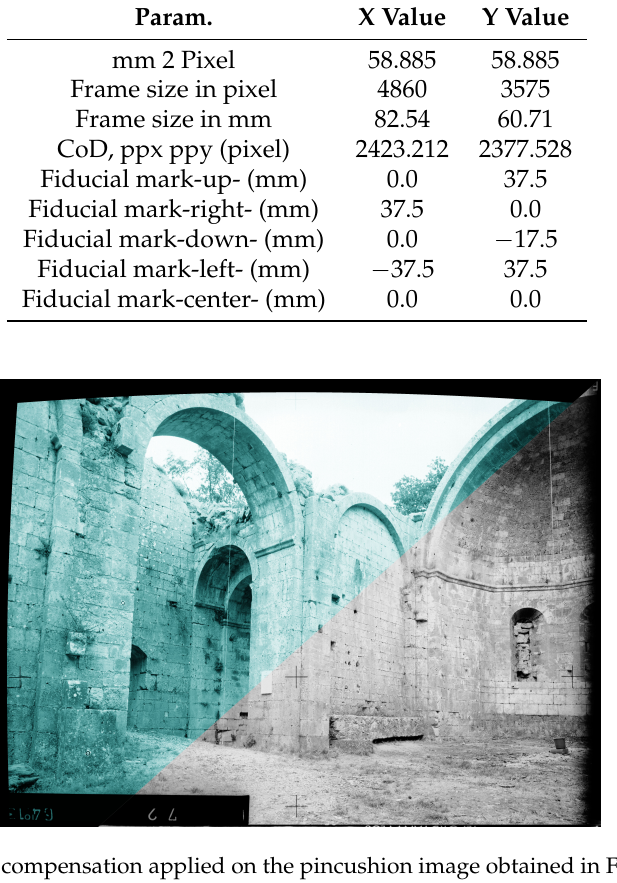
Figure 7. Distortion compensation applied on the pincushion image obtained in Figure 6b. In green the image corrected by inverse distortion; in black and white the original